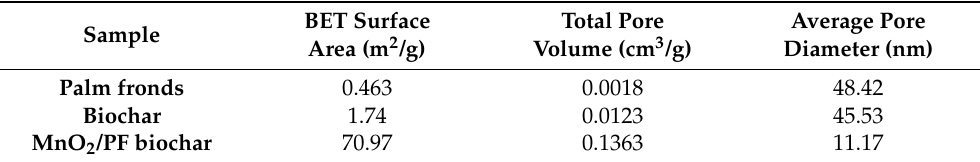
Figure 4. Hysteresis loops of palm fronds, biochar, and MnO 2 /PF biochar. Table 1. Pore textural characteristics of palm fronds, biochar, and MnO 2 /PF